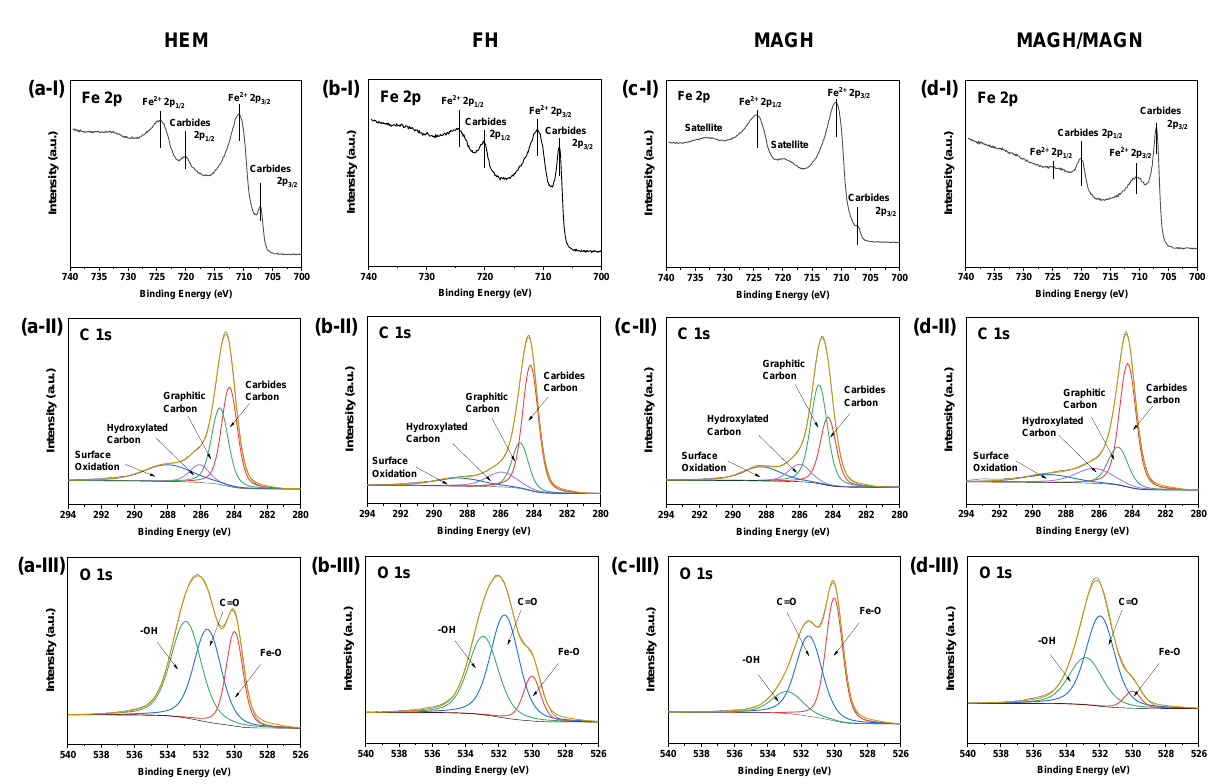
Figure 3. XPS spectra of (( a ) I–III HEM), (( b ) I–III) FH), (( c ) I–III) MAGH), (( d ) I–III)) MAGH/MAGN samples after the CO/H 2 syngas treatment.